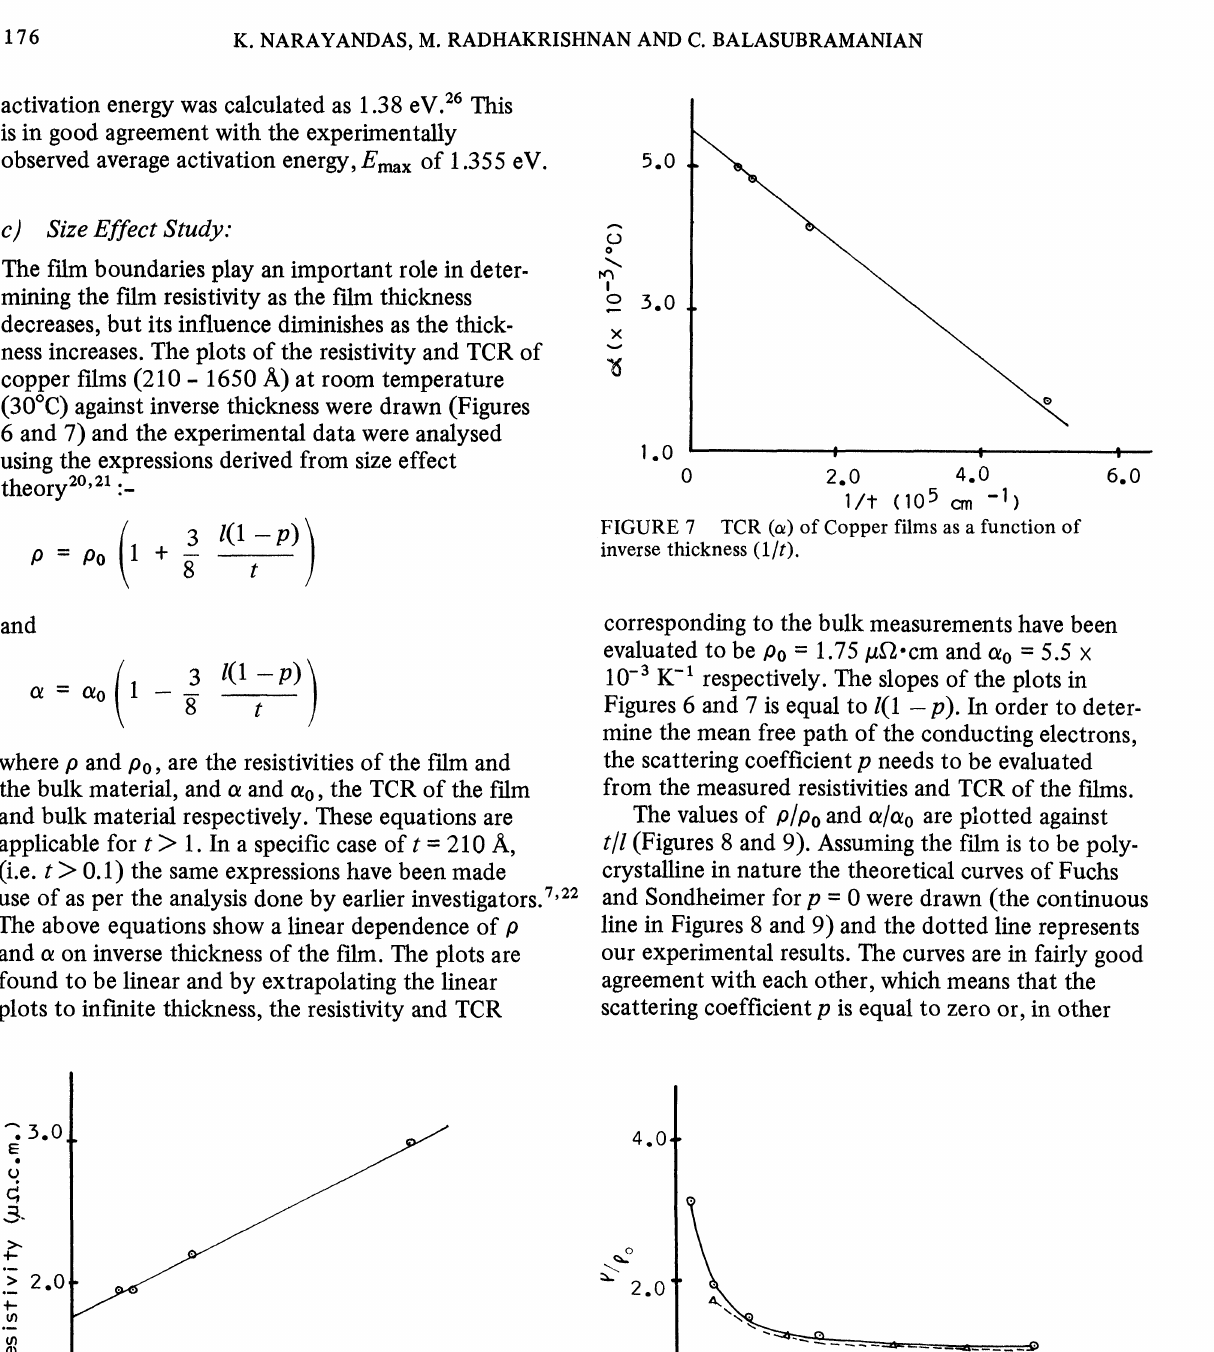
The variation of resistivity (p) with inverse thickness (l/t) for copper films.